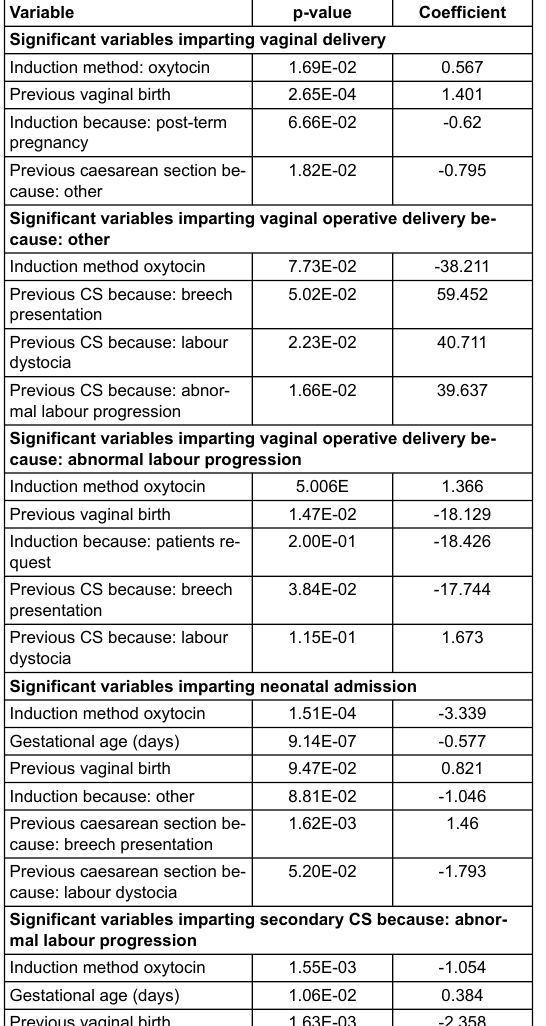
Table 3: Detailed analysis of clinically significant compound models in the cohorts investigated (induction method catheter and oxytocin after caesarean